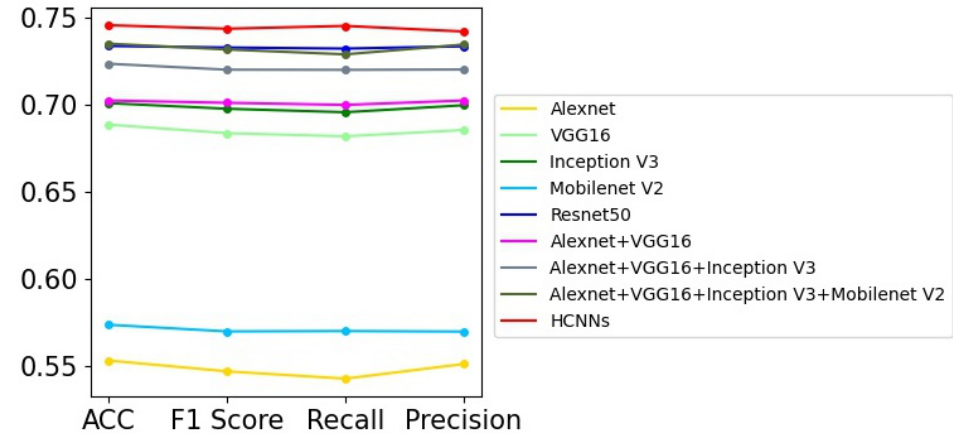
Figure 5. The curve graph of Table 3.